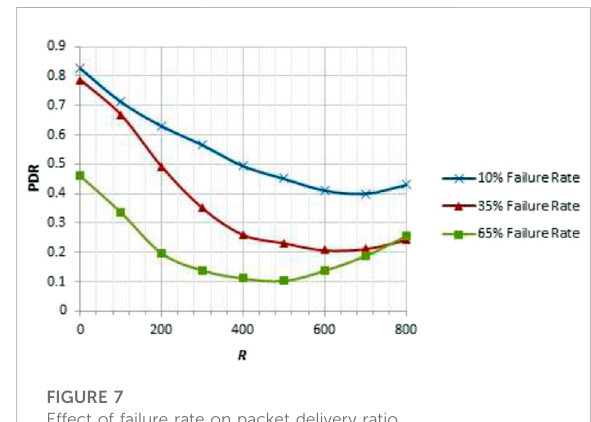
FIGURE 6 Effect of failure rate on load balancing ratio.